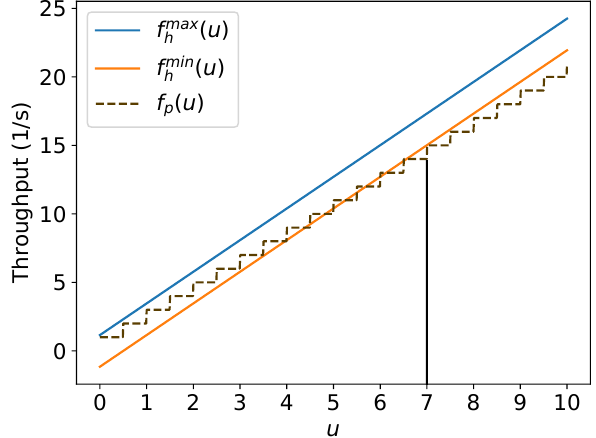
Figure 15. Example of u values such that f max